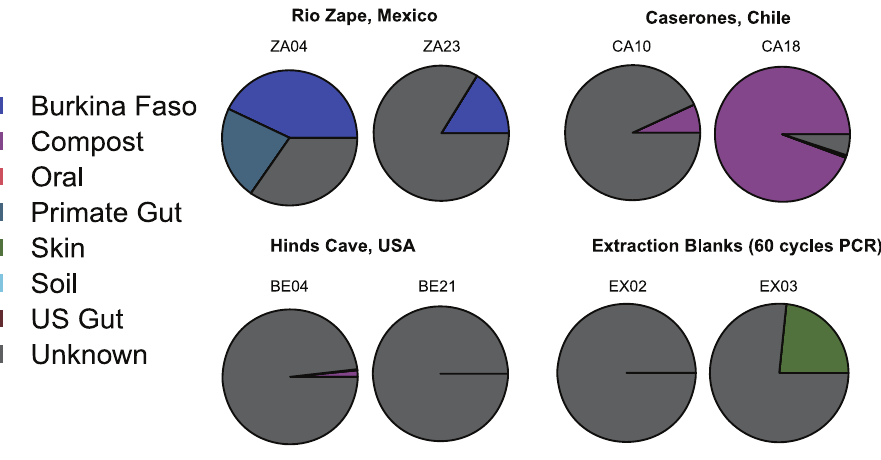
Figure 3. Bayesian source-tracking results for ancient coprolite samples. Both Rio Zape samples assign partially to the rural African children source, with sample ZA04 also containing a predicted partial match to the modern non-human primate gut source. Caserones sample CA18 assigns almost entirely to the compost source with relatively high confidence; sample CA10 is predicted with low confidence to contain a small proportion of compost (See Figure S5 for variability in proportion estimates). The sources for the Hinds Cave samples were unrecognized given our training data, resulting in nearly complete assignments to the ‘‘Unknown’’ source. When extraction blanks were subjected to 60 cycles of 16S PCR, the amplified microbial community signature assigns to either a skin community or unknown